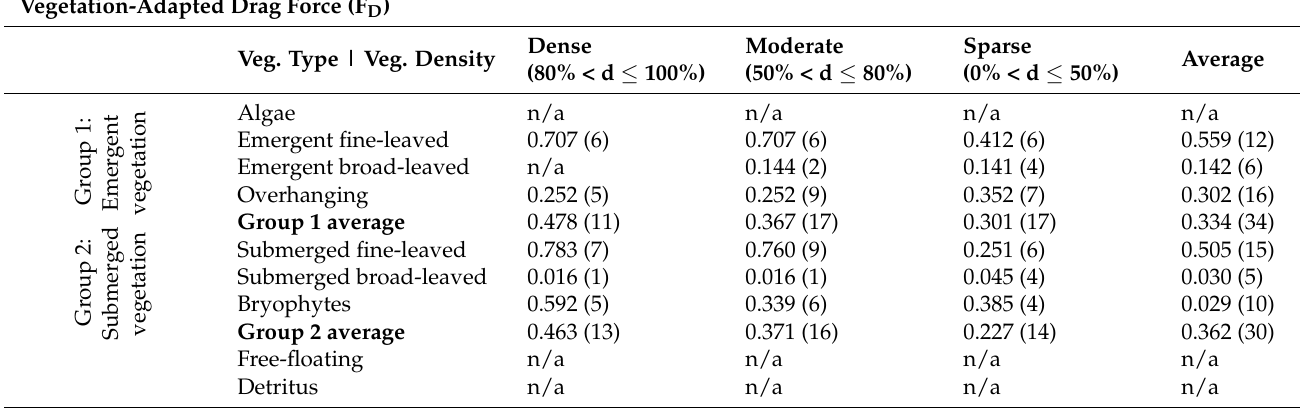
Table 2. Drag force (F D ; N/m 2 ) for emergent and submerged vegetation types in varying densities. Numbers in parentheses indicate the number of samples of each vegetation type. Vegetation-Adapted Drag Force (F D